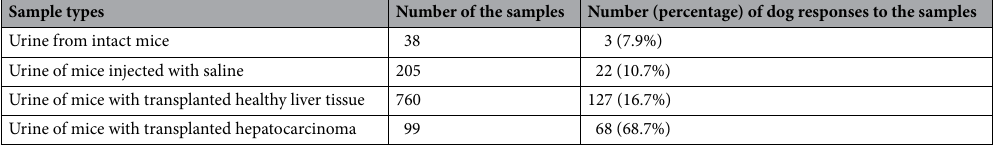
Table 3. Dogs’ responses to control and test samples.